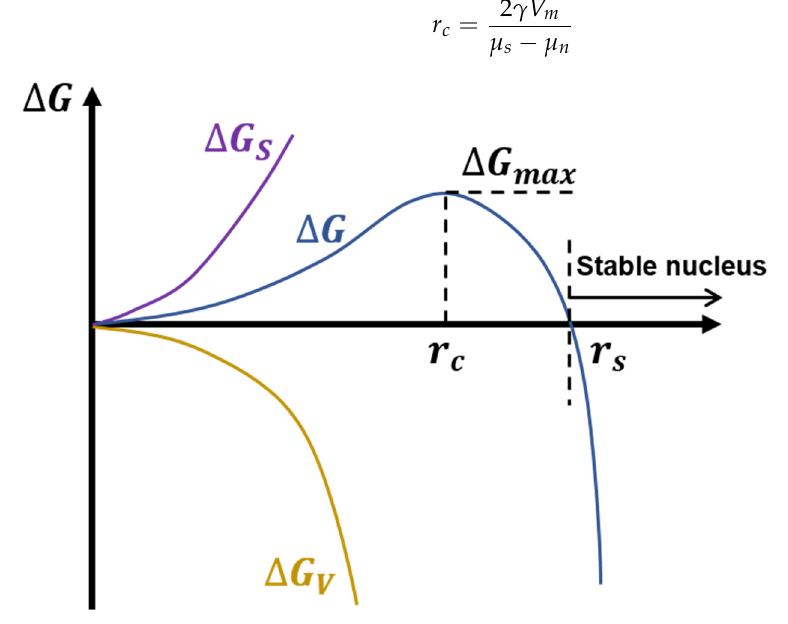
Figure 4. Schematic of the free energy change of a growing nucleus.